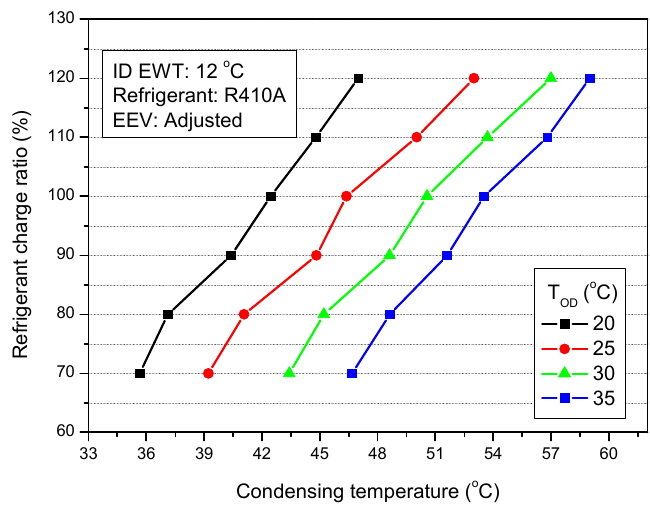
Figure 21. Relationship between refrigerant charge ratio and condensing temperature in cooling mode.